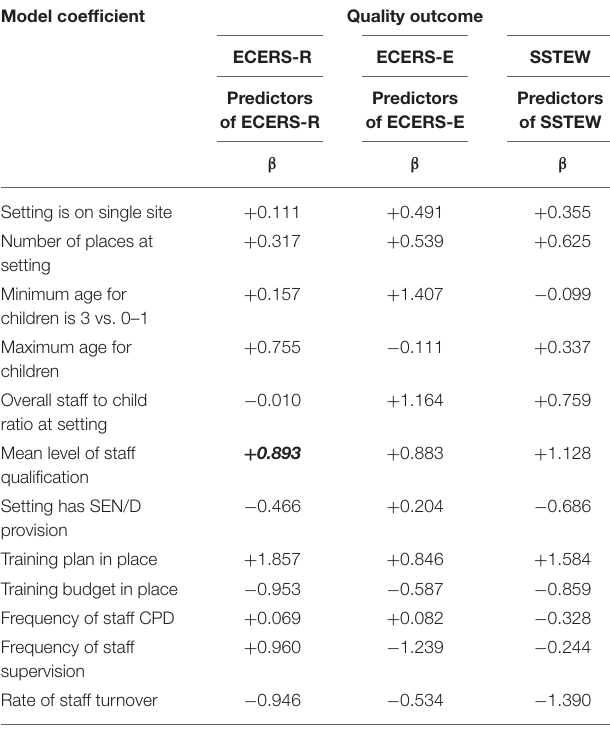
TABLE 7 | Results of regression models of quality in terms of structural characteristics; children’s centres. Model